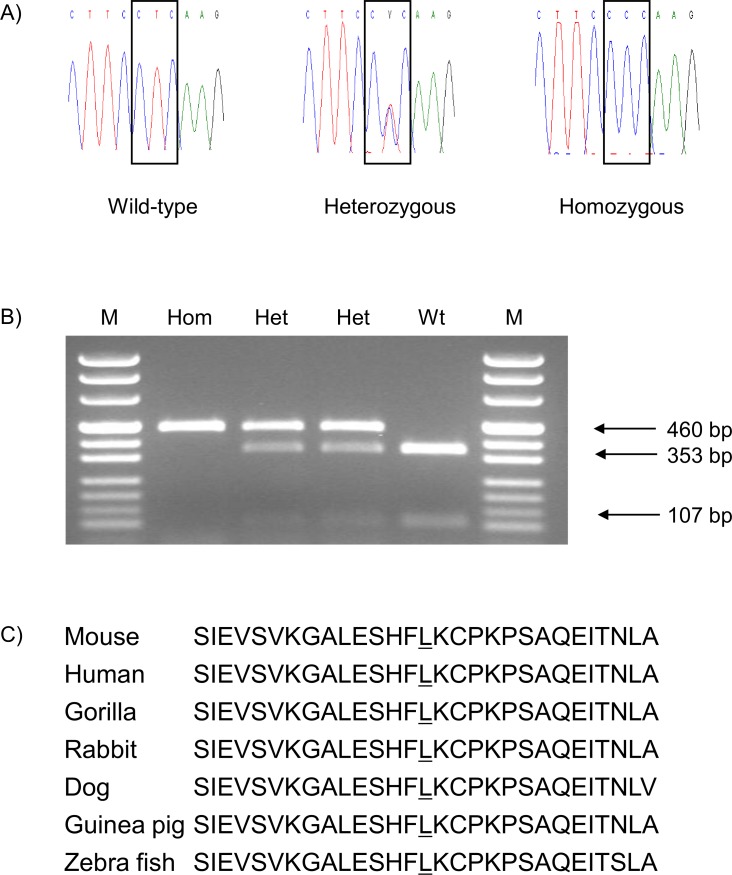
Analysis of Pou3f3 in wild-type and Pou3f3L423P mutant mice.(A) Electropherogram of the Pou3f3L423P mutation. The box shows the T→C point mutation at nt 1268 (ENSMUST00000054883) from the wild-type codon leucine (L) to the mutant codon proline (P) at amino acid position 423. (B) Genotyping of mice by allele-specific PCR-RFLP reaction. SmlI restriction digest of the 460 bp PCR product results in 353 bp and 107 bp fragments of the wild-type allele. Hom, Pou3f3L423P homozygous mutant; Het, Pou3f3L423P heterozygous mutant; Wt, wild-type; M, pUC Mix 8 marker, MBI Fermentas. (C) Partial protein sequence alignment of the homeobox domain of murine POU3F3 with other species. The underlined amino acid residue shows the position of the Pou3f3L423P mutation.